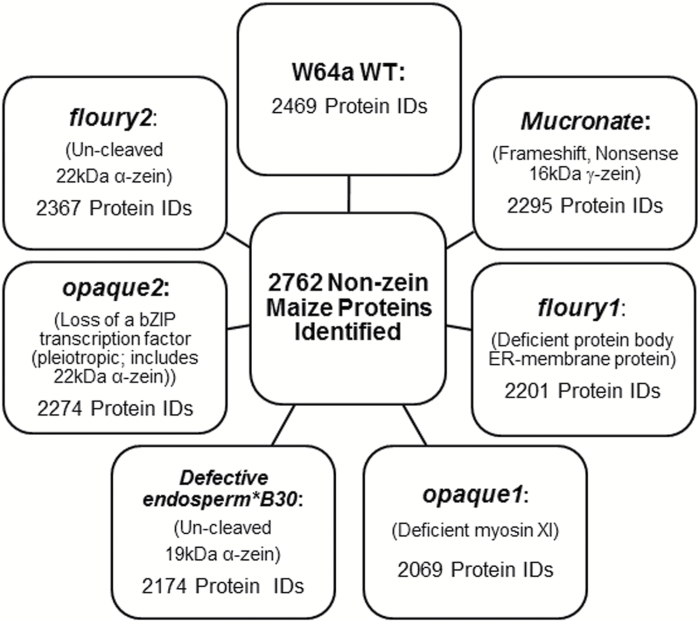
Total proteins identified in all opaque mutants. A total of 2762 proteins were identified by LC-MS/MS in the non-zein fraction of the maize endosperm. The number of proteins identified in each sample is shown and the molecular basis of the mutation for each opaque is given for reference. W64A WT had the most identifiable proteins followed by fl2, Mc, o2, fl1, DeB30, and o1.